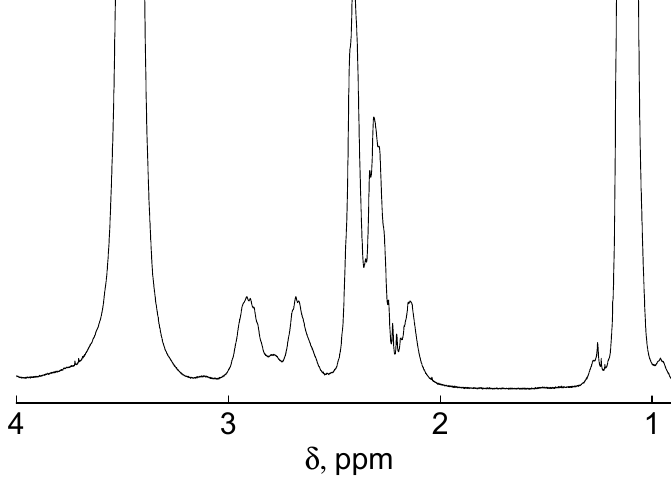
Figure 6. 1 H NMR spectrum of star-shaped C8A-(PEtOx-b-PiPrOx).